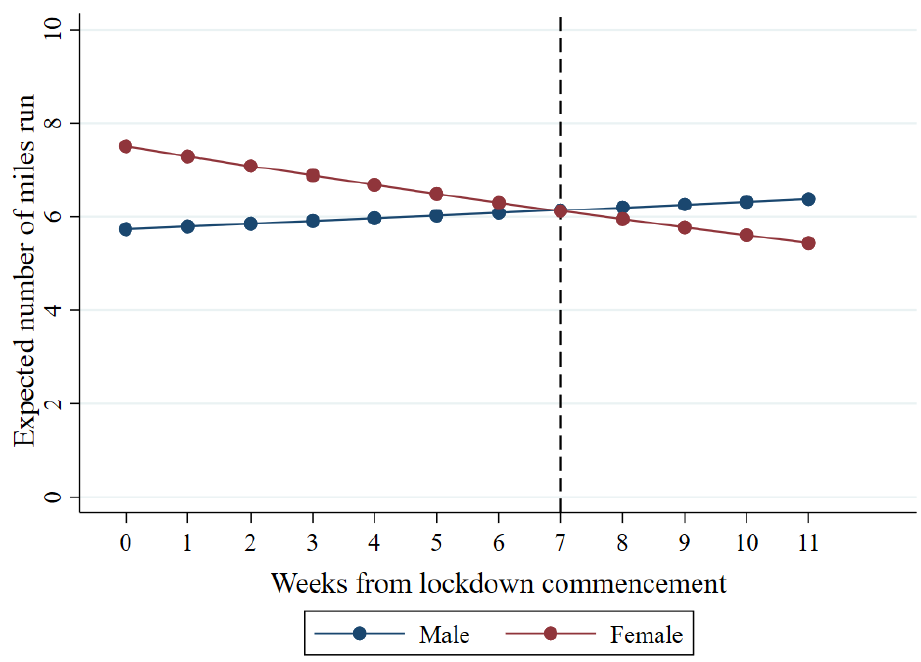
Figure 2. Trajectory of miles per week by gender. The vertical dashed lines indicate easing of lockdown restrictions (11 May